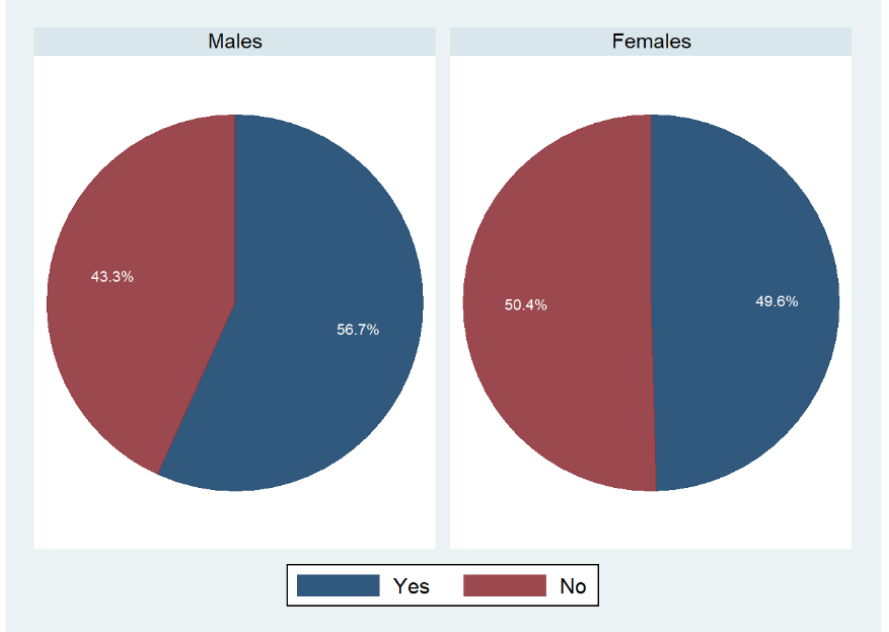
Figure 3. Sharing of meal planning and preparation duties stratified by gender: an overview. Weighted percentages, n = 9087; p < 0.001 based on a Rao – Scott test exploring potential associations between main person shopping and sex.